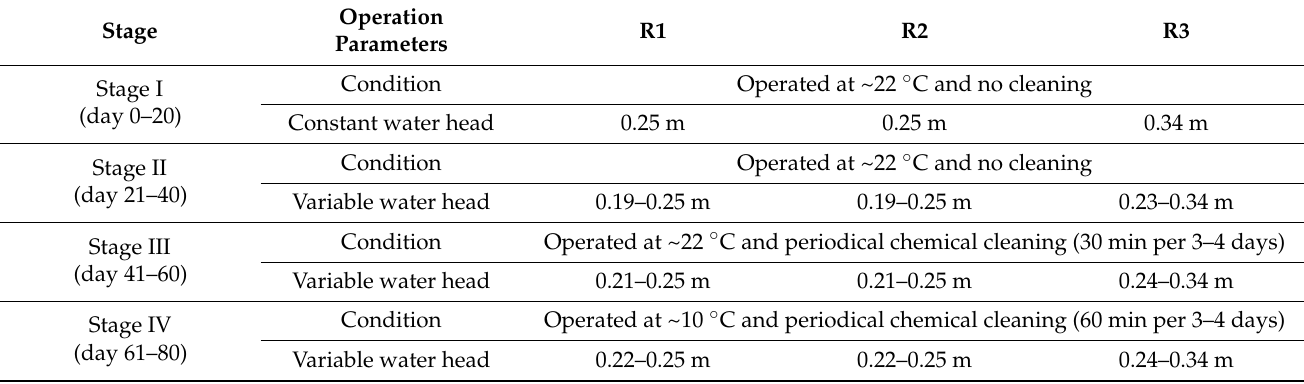
Table 1. The operation conditions of GDM reactors.